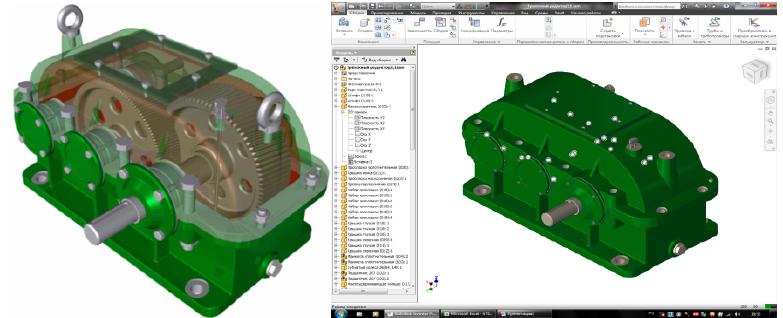
Fig. 2. Models for virtual laboratory works for the "Machine parts" course